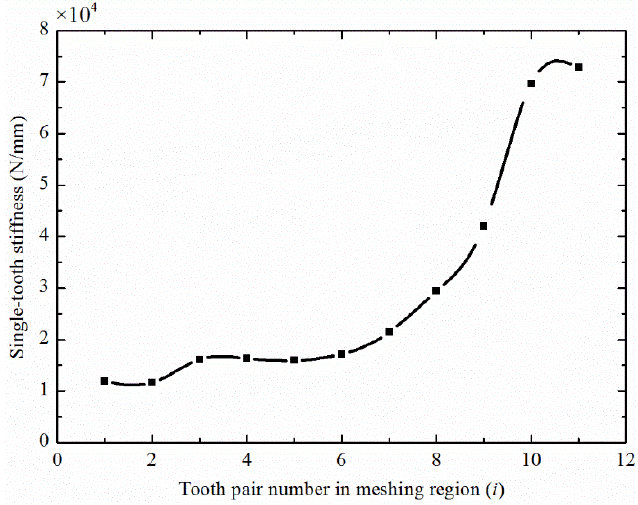
Figure 27. Comprehensive meshing stiffness of disposable HD.